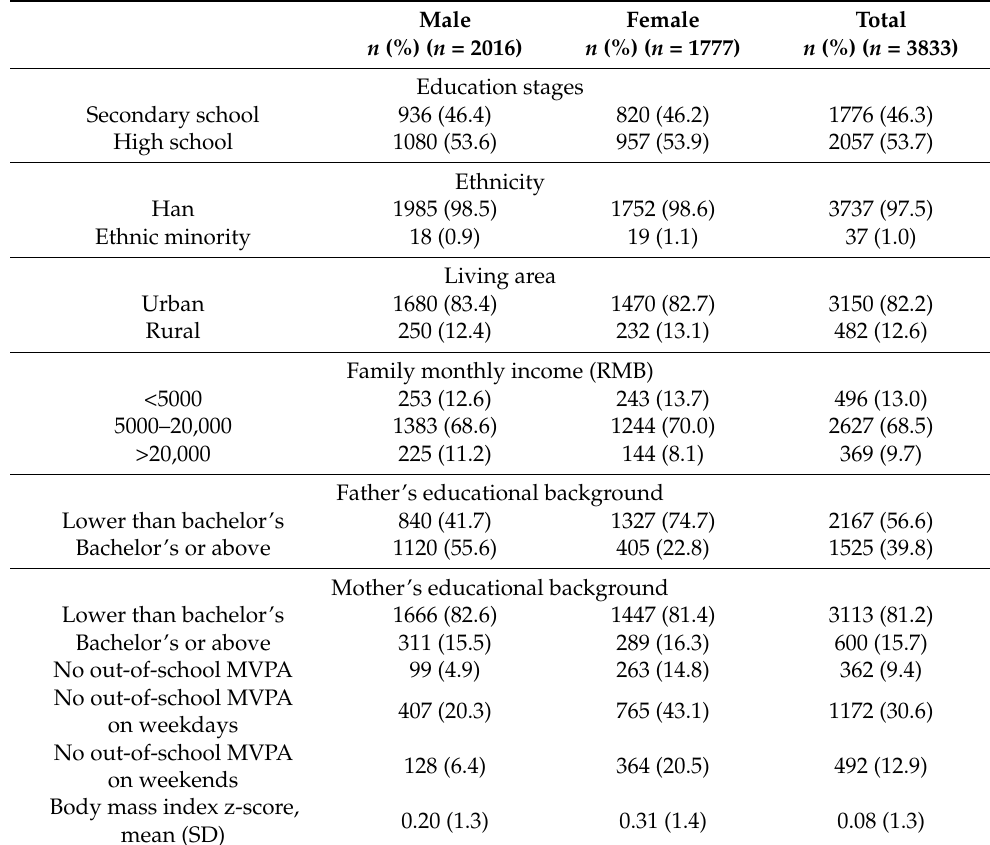
Table 1. Characteristics of participants